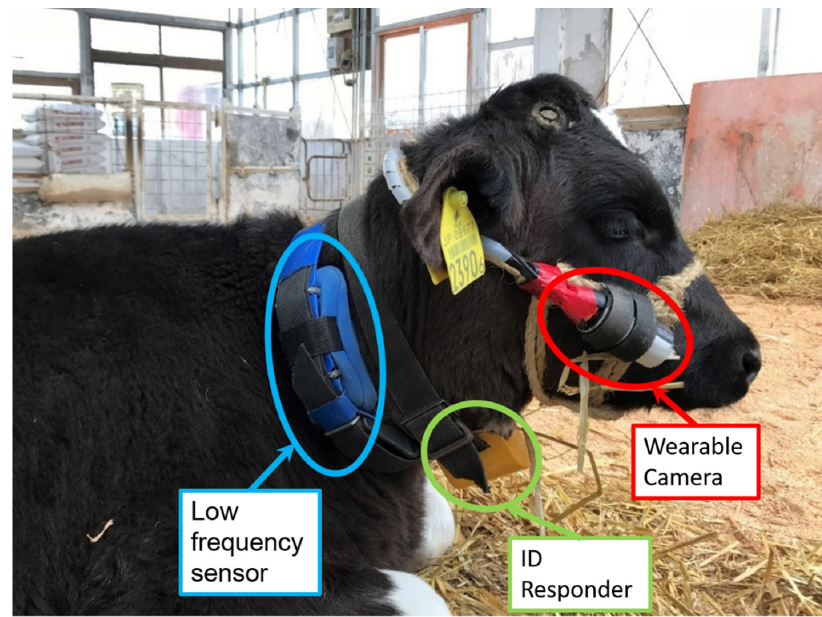
Figure 2. The halter and camera attached to a calf during the study investigating the suitability of wearable cameras for observing juvenile bovine behavior. The wearable camera is shown in the red circle. ID responder shown in the green circle is for automatic milk feeder. The low-frequency sensor shown in blue is for obtaining rumination data for another experiment, the results of which are not presented in this paper.